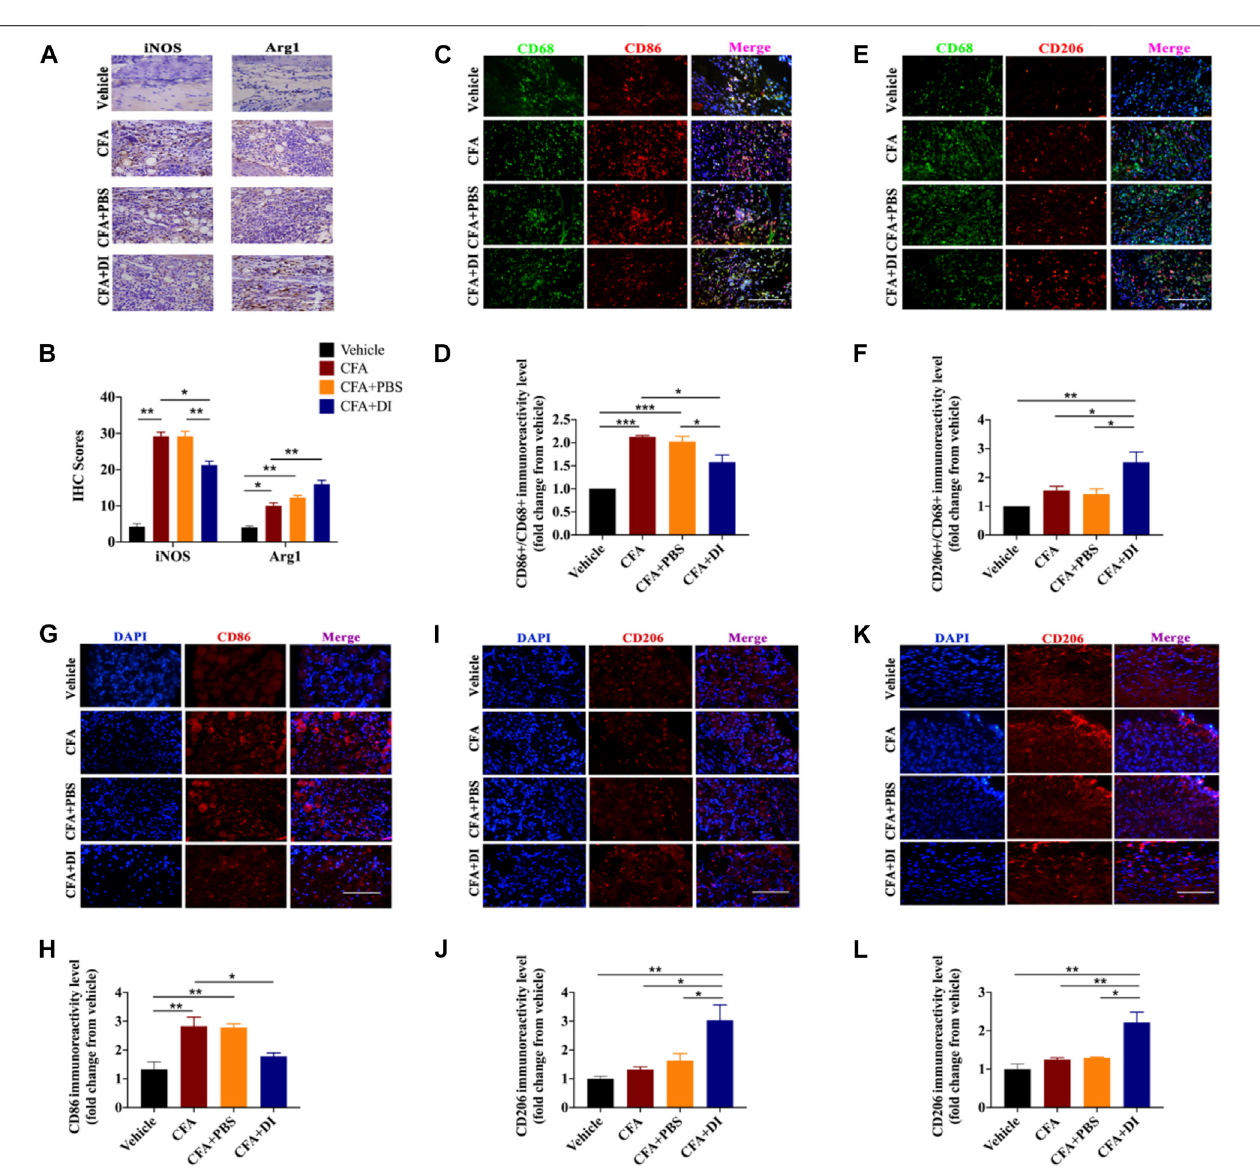
FIGURE 5 | Effect of DI on macrophage/microglia polarization. (A) Photomicrographs representing iNOS and Arg1 immunoreactivity in each group. Arrowheads indicate positive cells. (B) iNOS score and Arg1 score were detected the same as above. F group (3, 12) = 113.0 for iNOS. F group (3, 12) = 42.18 for Arg1. The scale bar represents 50 μ m. (C,E) Immuno fl uorescent staining for CD68 (Green), CD86 (red), and CD206 (red), and nuclei were counterstained using DAPI (blue). The scale bar represents50 μ m.Representativeimmuno fl uorescencestaininglevelfor CD86+/CD68+,F group (3, 8) =28.14for (D) and CD206+/CD68+,F group (3, 8)=9.312 for (F) , fold change versus the vehicle group. Immunostaining of CD86 (G) and CD206 (I) in DRG. The scale bar represents 50 μ m. Representative immuno fl uorescence staining level for CD86, F group (3, 8) = 11.12 for (H) and CD206, F group (3, 8) = 8.999 for (J) , fold change versus the vehicle group. (K) Immunostaining of CD206 in the spinal cord. The scale bar represents 50 μ m. (L) Representative immuno fl uorescence staining level for CD206, F group (3, 8) = 12.42, fold change versus the vehicle group. This experiment was repeated independently 3 times and similar results were obtained. * p < 0.05, ** p < 0.01 and *** p < 0.001.